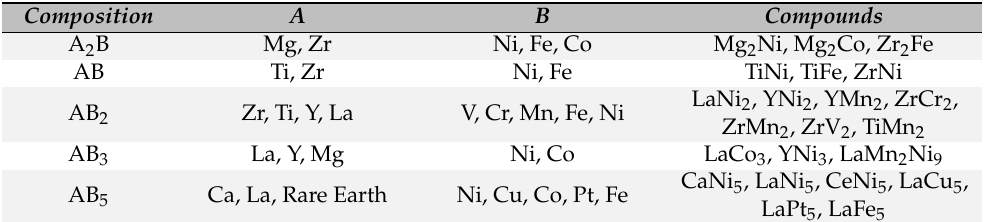
Table 1. Examples of intermetallic hydrides for solid-state hydrogen